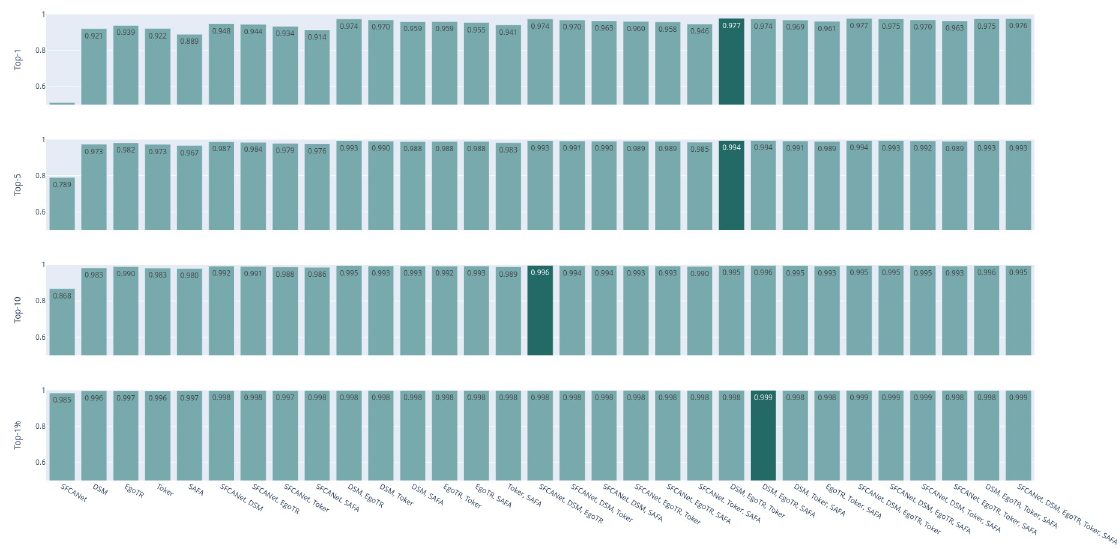
Fig 6. CVUSA combinations for the soft-voting